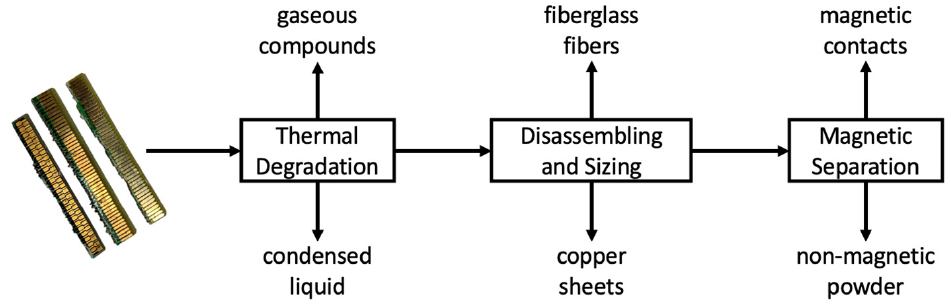
Figure 2. The proposed chemical processing route for the received WEEE samples.